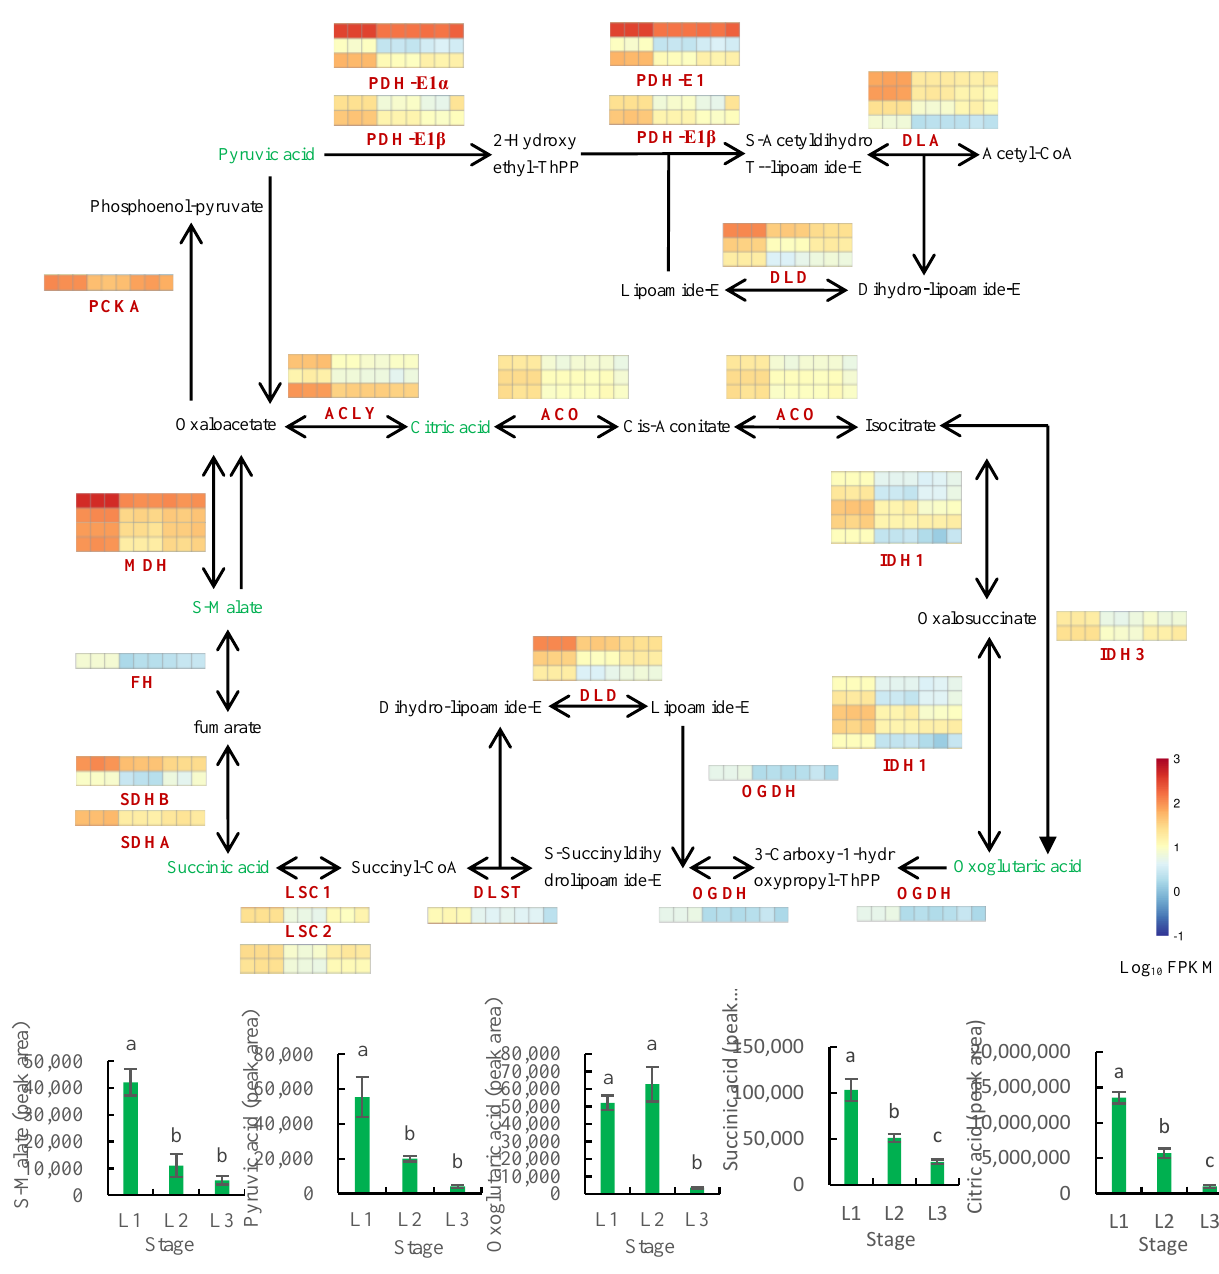
Figure 10. Analysis of the TCA cycle pathway in walnut embryos. Note: the metabolite peak areas are shown in the cylindrical map, while the expression values of genes are in the thermal map, which shows the homogenization values of genes. L1 was 60 DAP, L2 was 90 DAP, and L3 was 120 DAP. The nine squares in each horizontal row correspond to the nine samples (L1_1, L1_2, L1_3, L2_1, L2_2, L2_3, L3_1, L3_2, and L3_3). Bars represent the mean ± SE (n = 6). Bars with different lowercase letters (a, b, c) are significantly different ( p < 0.05). PDH − E1 α , pyruvate dehydrogenase